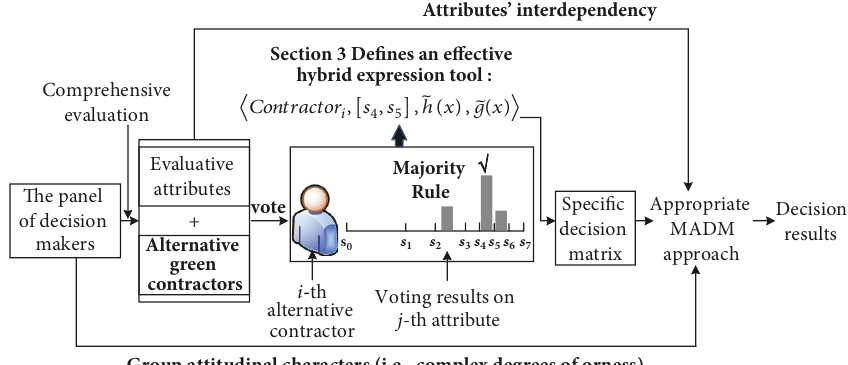
Figure 1: Conceptual MADM model for tackling complexity in green contractor